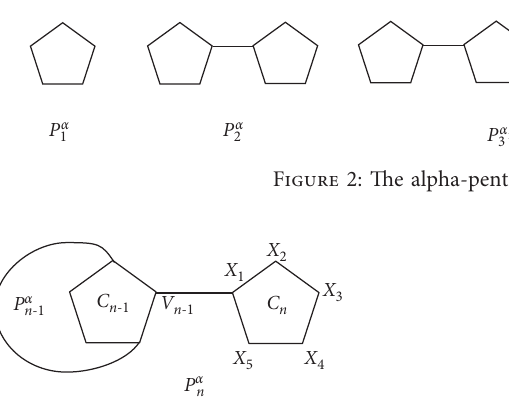
Figure 3: An alpha-pentachain P α